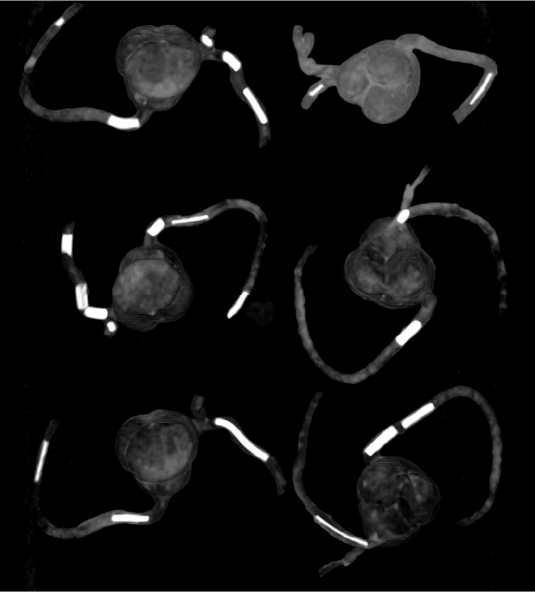
Figure 13. Coronal maximum-intensity projection images showing the calcified plaques (with dif- ferent diameters and lengths) in six 3D printed coronary models. Reprinted with permission under the open access from Sun et al. [83].